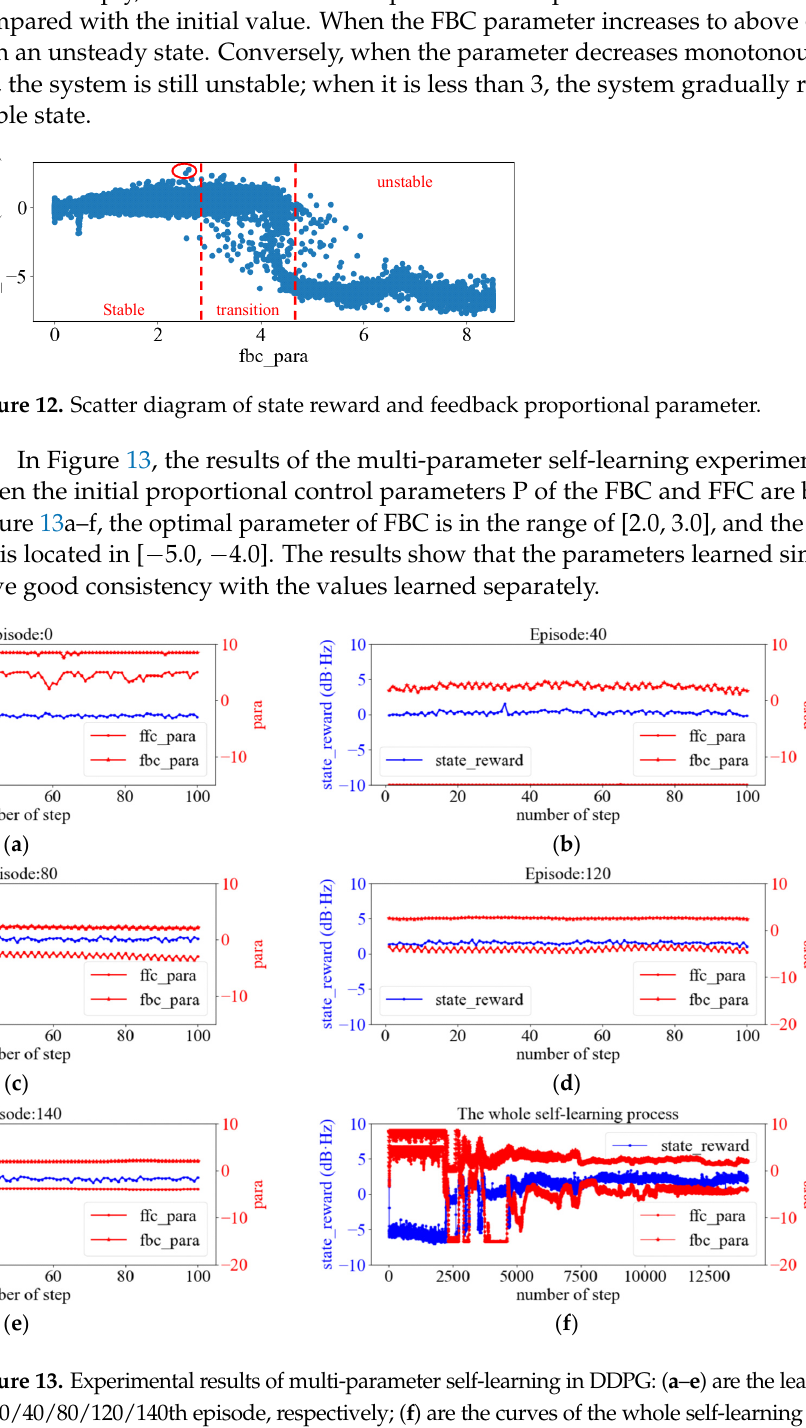
( f ) Figure 13. Experimental results of multi-parameter self-learning in DDPG: ( a – e ) are the learning curves of the 0/40/80/120/140th episode, respectively; ( f ) are the curves of the whole self-learning process.